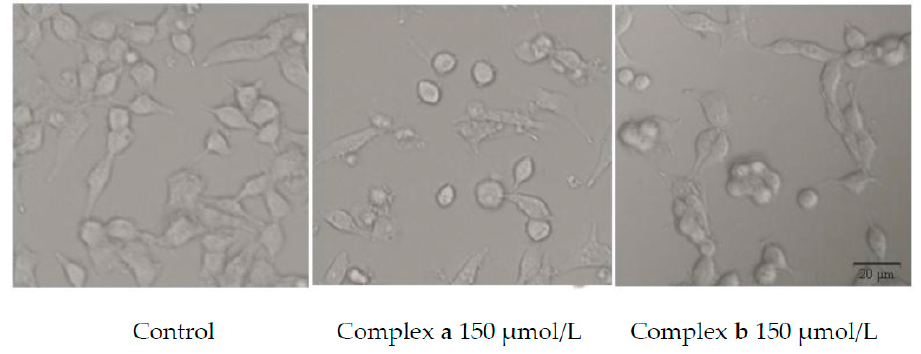
Figure 4. Effect of complexes a / b on the A549 cell morphology.